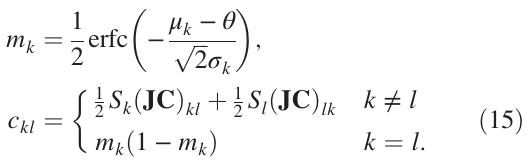
FIG. 1. Consistent Gaussian approximation for the mean activity and covariance matrix in a random network of binary neurons. (a) Theoretical prediction of mean activities (15) versus simulation results (black is for excitatory; gray is inhibitory). The diagonal is indicated by the dashed line. Lower inset: Mean activity averaged over excitatory and inhibitory neurons (light gray is for simulation; darker gray is for theory). Black error bars show standard error of the mean obtained from 20 simulations (not visible, below line width). Upper inset: Width of distribu- tion of mean activities. (b) Theoretical prediction (15) versus simulated covariance. Only cross-covariances are shown, as autocovariances follow trivially by Eq. (3) from the mean activities. Lower inset: Mean covariances averaged over excitatory-excitatory, excitatory-inhibitory, and over inhibitory- inhibitory neuron pairs (light gray is for simulation; darker gray is for theory). Error bars show the standard error of the mean obtained from 20 simulations. Upper inset: Width of the distributions of covariances. Network parameters: Number of excitatory ( N E ¼ 500 ) and inhibitory neurons ( N I ¼ 125 ), threshold θ ¼ − 5 . 5 , excitatory coupling strength J ij ¼ J ¼ 1 , ∀ j ∈ E , inhibitory coupling strength J − 6 J , ∀ j ∈ I , and ij ¼ fixed in-degree homogeneous random network with connection probability p ¼ 0 . 2 . Results are averaged over 20 simulations with T ¼ 2 ; 000 ; 000 ms each. Simulations were performed using the NEST simulator [53]. Theoretical predictions are obtained by damped fixed-point iteration